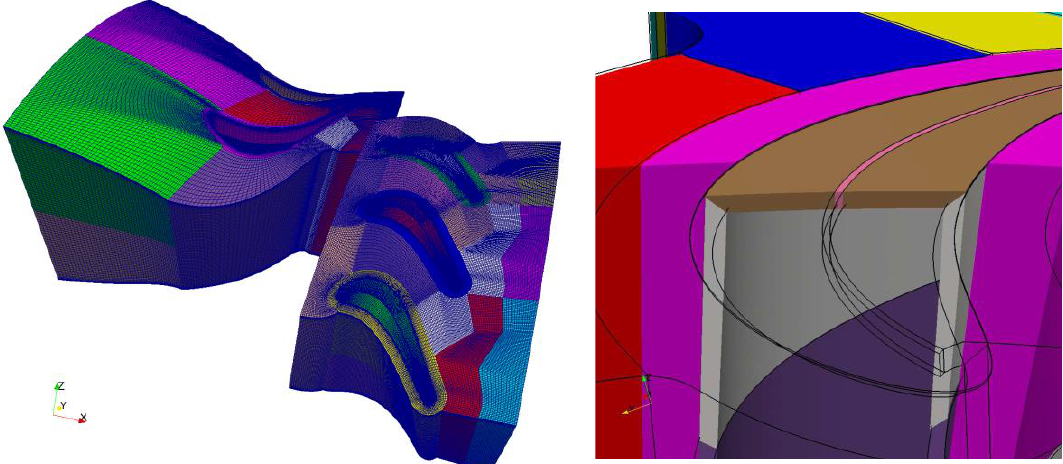
Figure 2. Computational mesh consisting of 57 blocks and nearly 10 million cells ( left ), block arrangement in the tip leakage region ( right ).